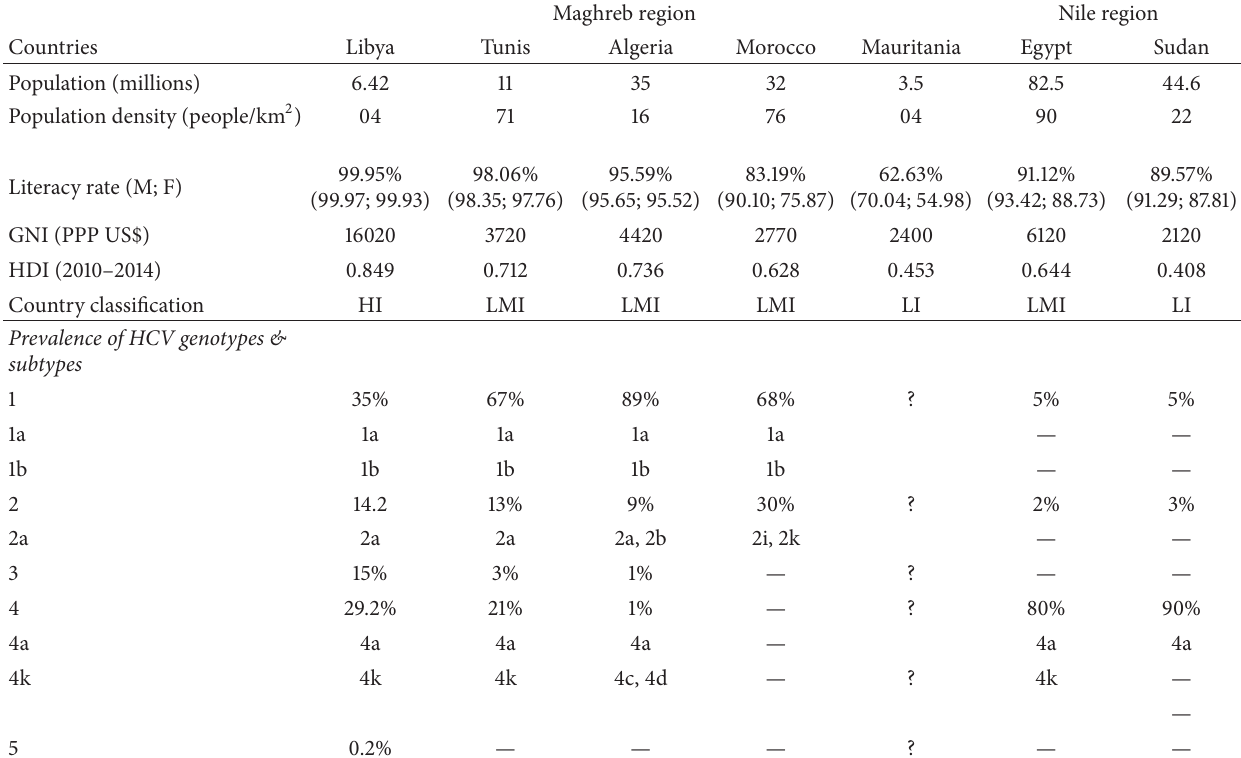
Table 1: Prevalence of HCV, development parameters, and genotype distribution in North African